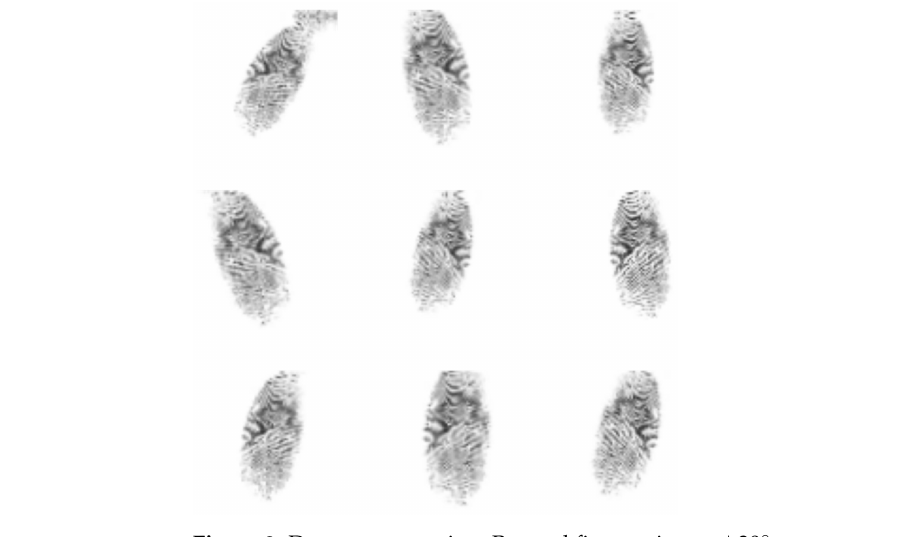
Figure 2. Data augmentation. Rotated fingerprint on ± 30 ◦ .